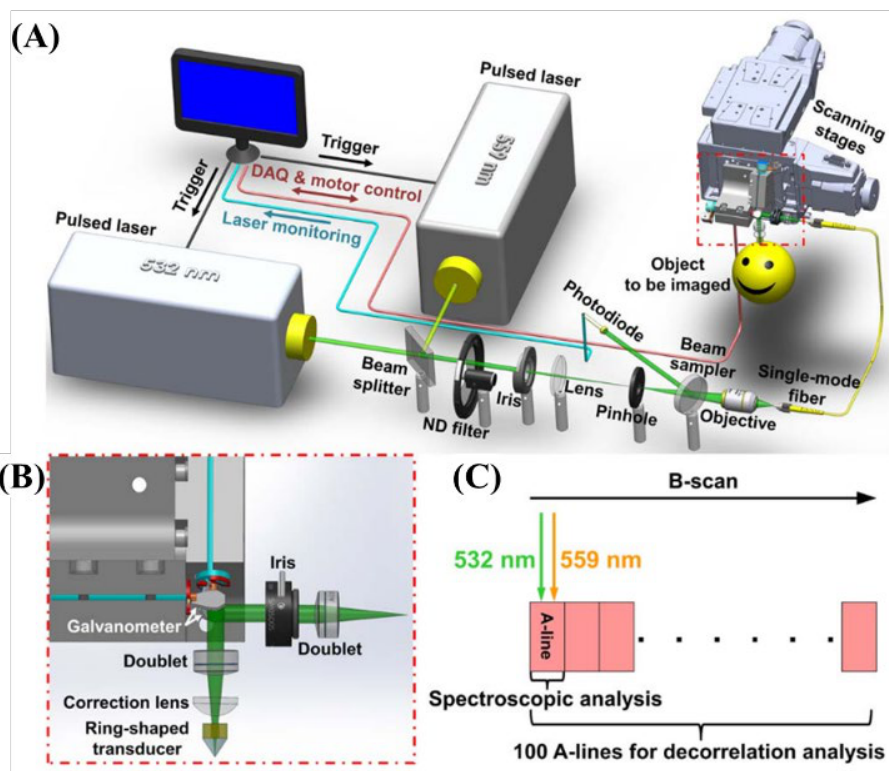
Figure 21. Multi-parametric PAM platform. ( A ) System schematic (DAQ: data acquisition). ( B ) Blow-up of the scan head boxed in ( A ). ( C ) Scanning mechanism for simultaneous acquisition of vascular anatomy, oxygen saturation, and blood flow. Reprinted from Ning et al., Opt. Lett., 2015, 40, 6: 910–913 [39], with permission of the Optical Society of America.